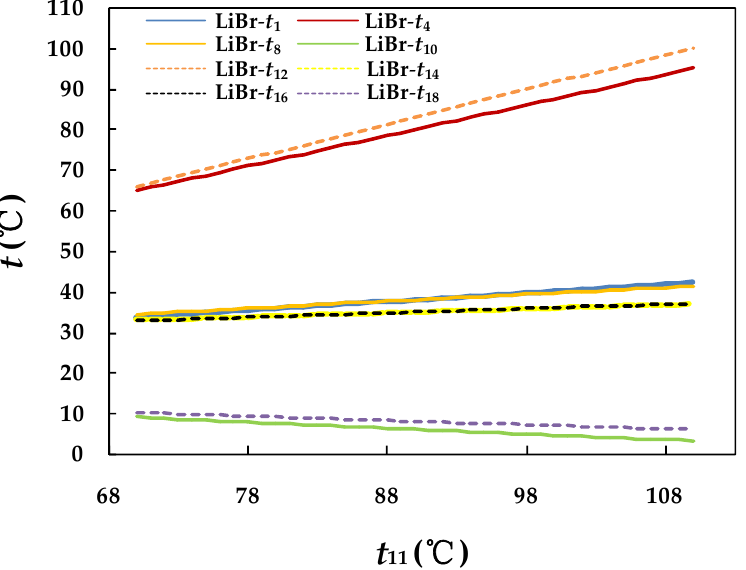
Figure 13. Variation of COP and exergy efficiency with the hot water inlet temperature for the two absorption chillers.